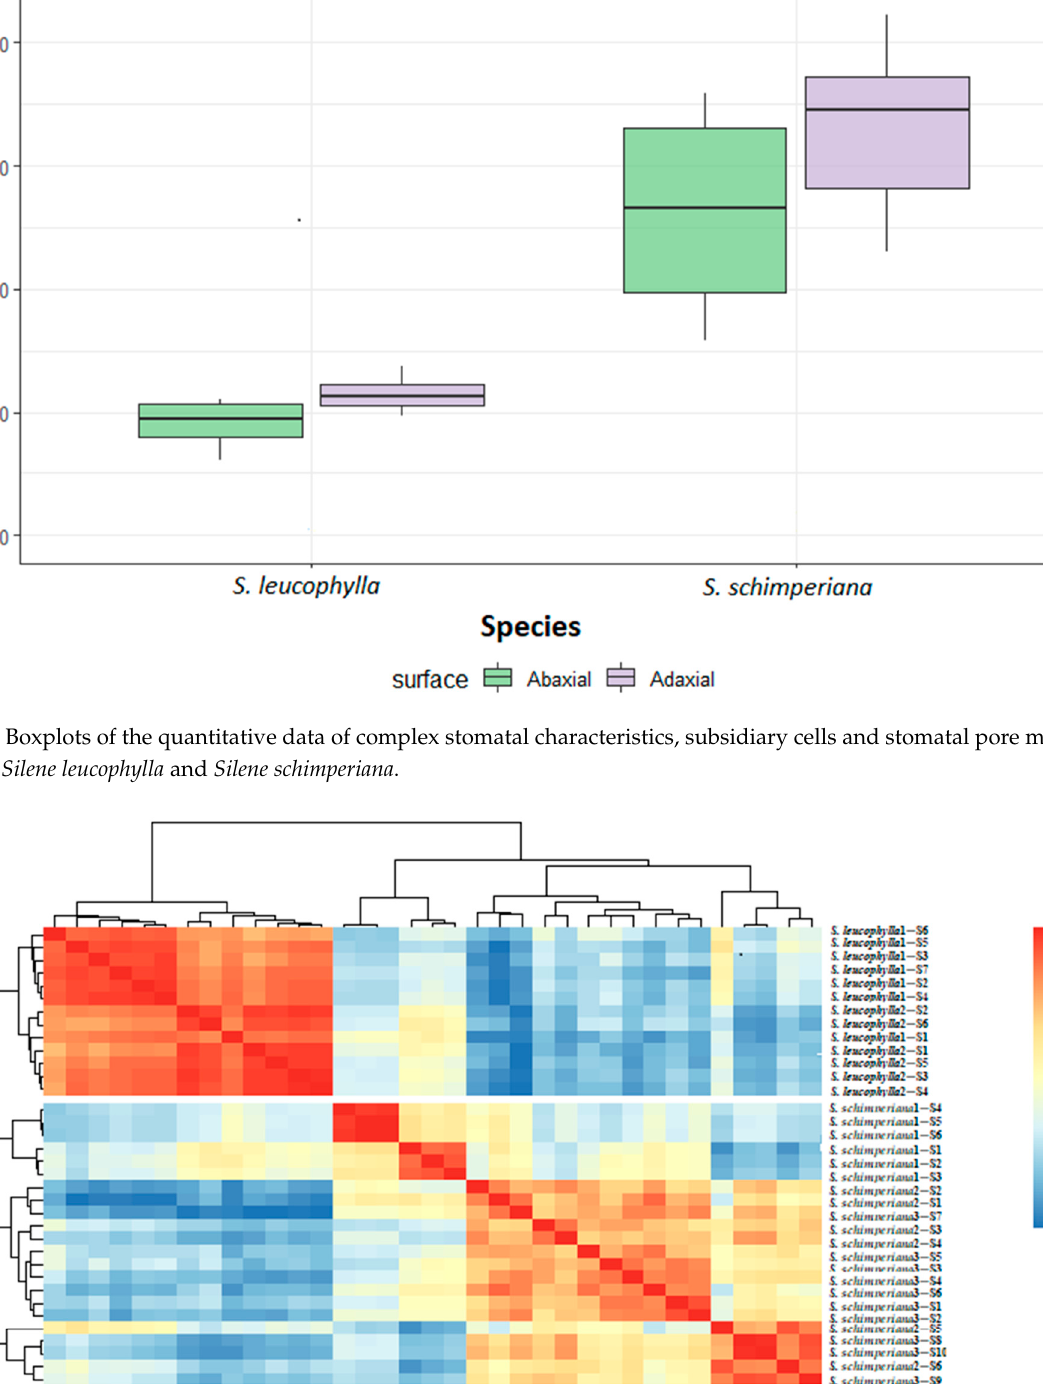
Figure 7. Correlogram between quantitative traits of Silene leucophylla and Silene schimperiana . Positive and negative corre- lations are displayed in blue and red color, respectively. Correlation coefficients are proportional to color intensity.